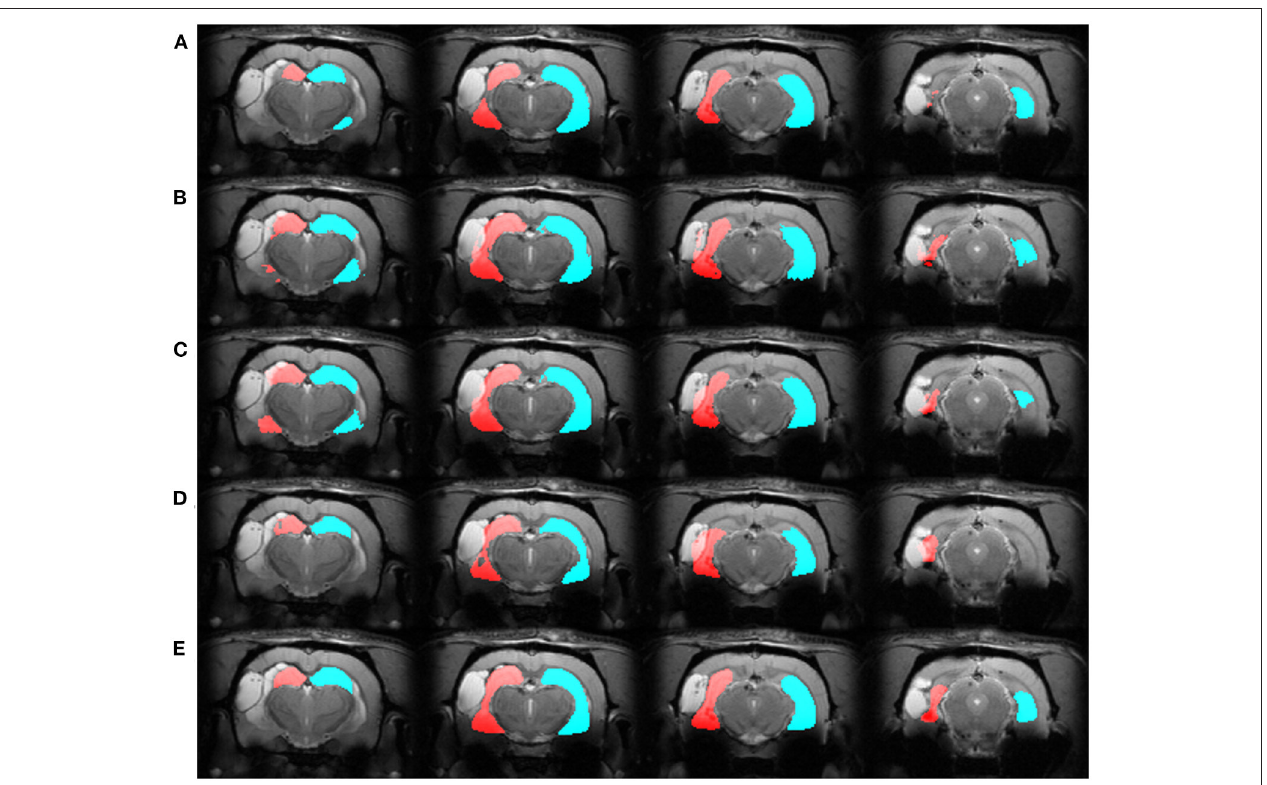
FIGURE 3 | Segmentation maps in four representative slices from a randomly selected animal from the EPITARGET dataset, at the 21-days timepoint. Maps are obtained with: (A) MU-Net; (B) STEPS, (C) Majority voting. (D) Single-atlas segmentation. (E) Displays the ground-truth segmentation. From left to right, slices are located at approximately − 3.5, − 4.5, − 5.5, − 6.5mm from bregma. Red: hippocampus ipsilateral to the lesion; blue: hippocampus contralateral to the lesion. Note how in this case all methods except MU-Net-R mislabel a portion of the lesion as